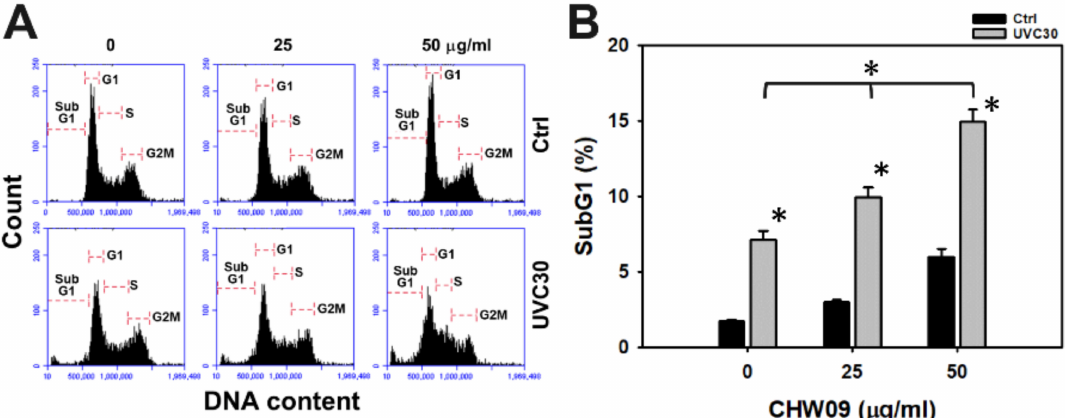
Figure 2. Change of subG1 percentage in oral cancer Ca9-22 cells after UVC / CHW09 combined treatments. Cells were pretreated with UVC irradiation (0 and 30 J / m 2 ) and / or post-treated with CHW09 (control, 25, and 50 µ g / mL) for 24 h. ( A ) Representative pattern of cell cycle analysis for UVC and / or CHW09 treatment. ( B ) Statistics in Figure 2A. Data, mean ± SD ( n = 3 independent experiments). For multiple comparison, significance of the di ff erence was examined by one-way ANOVA and the Tukey HSD Post Hoc Test. *, p < 0.0001. * without line indicates the significance between control and UVC30. * with line indicates the significance between UVC30 / CHW09 and others. 2.3. UVC / CHW09 Combined Treatment Shows High Annexin V Content to Oral Cancer